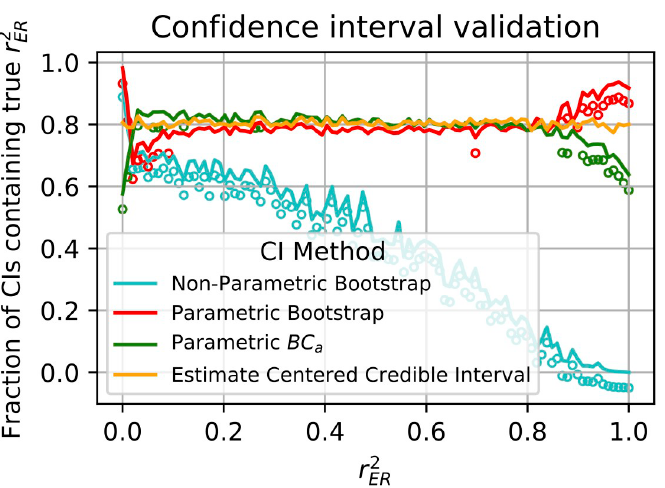
Fig 6. Comparison of four methods for computing confidence intervals for ^ r 2 spanning the full range of true ER correlation. The fraction of times the CI contained the true value is plotted for each method (see line style inset) as a function of the true correlation value, r 2 , at 100 values linearly spaced between 0 and 1. The target α -level was 0.8. ER Open circles indicate that the fraction deviated from 0.8 significantly ( p < 0.01, Bonferroni